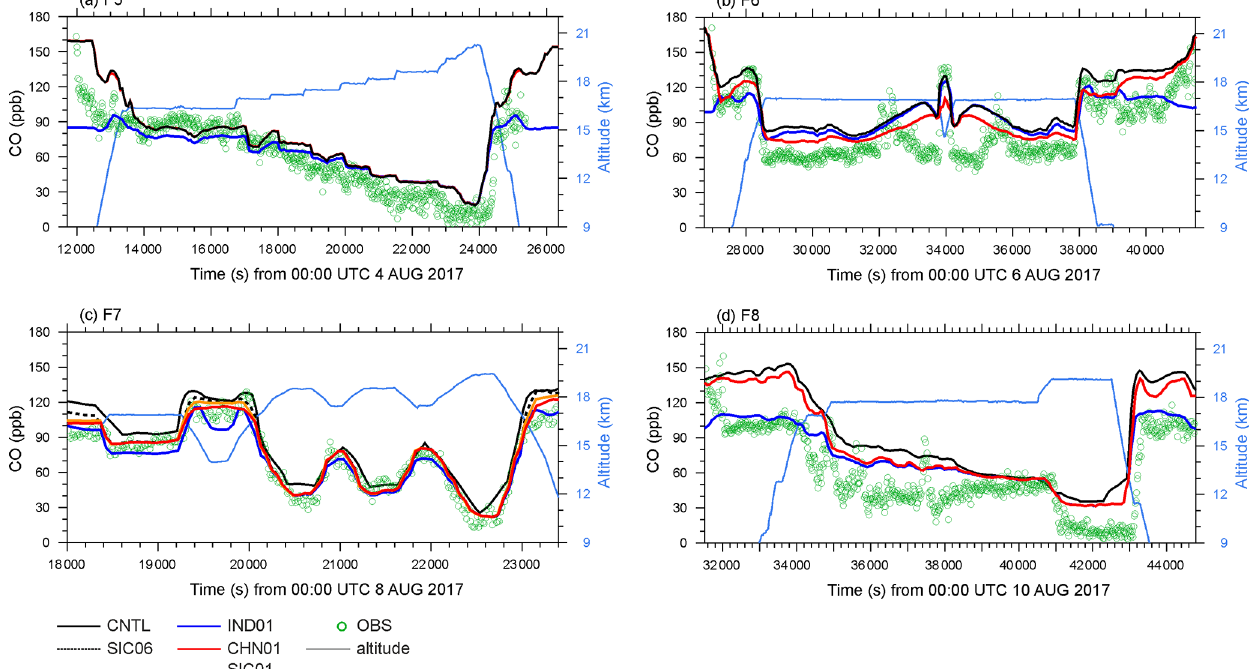
Figure 4. Comparison of CO concentration (ppbv) of AMICA-measured (green circles) and Meso-NH-derived (black lines) along the Stra- toClim flight tracks (a) #5 on 4 August, (b) #6 on 6 August, (c) #7 on 8 August, and (d) #8 on 10 August 2017 (for the locations, see Fig. 1). The simulated CO concentration by SIC01, CHN01, and IND01 along the flight tracks are displayed by orange, red, and blue solid lines, respectively. Flight altitudes are displayed by light blue lines. In (c) , the SIC06-produced CO concentration along the flight track is displayed by a dotted